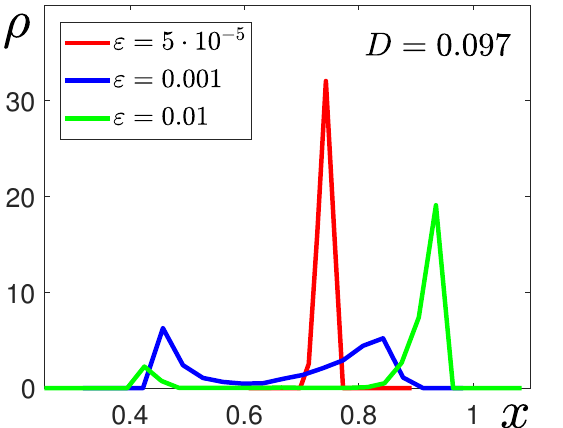
Figure 6. Stochastic splitting of the cycle in system (2) with D = 0.097: transformations of the probability density function ρ ( x ) .